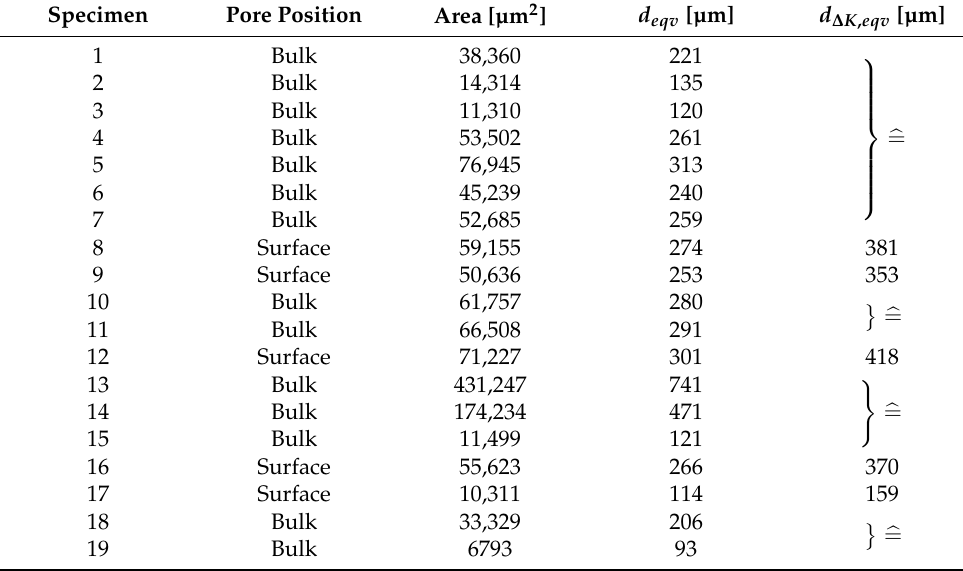
Figure 9. Cumulative probability of occurrence dependent on equivalent and ∆ K -equivalent defect size. Table 5. Position, size and equivalent diameter of the detected